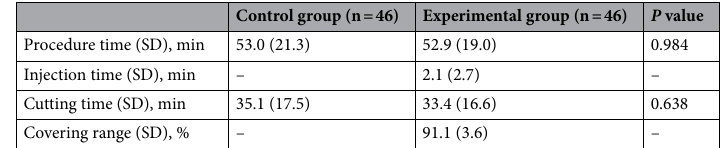
Table 2. Details of the endoscopic submucosal dissection procedures. Data are mean (SD) unless otherwise stated.